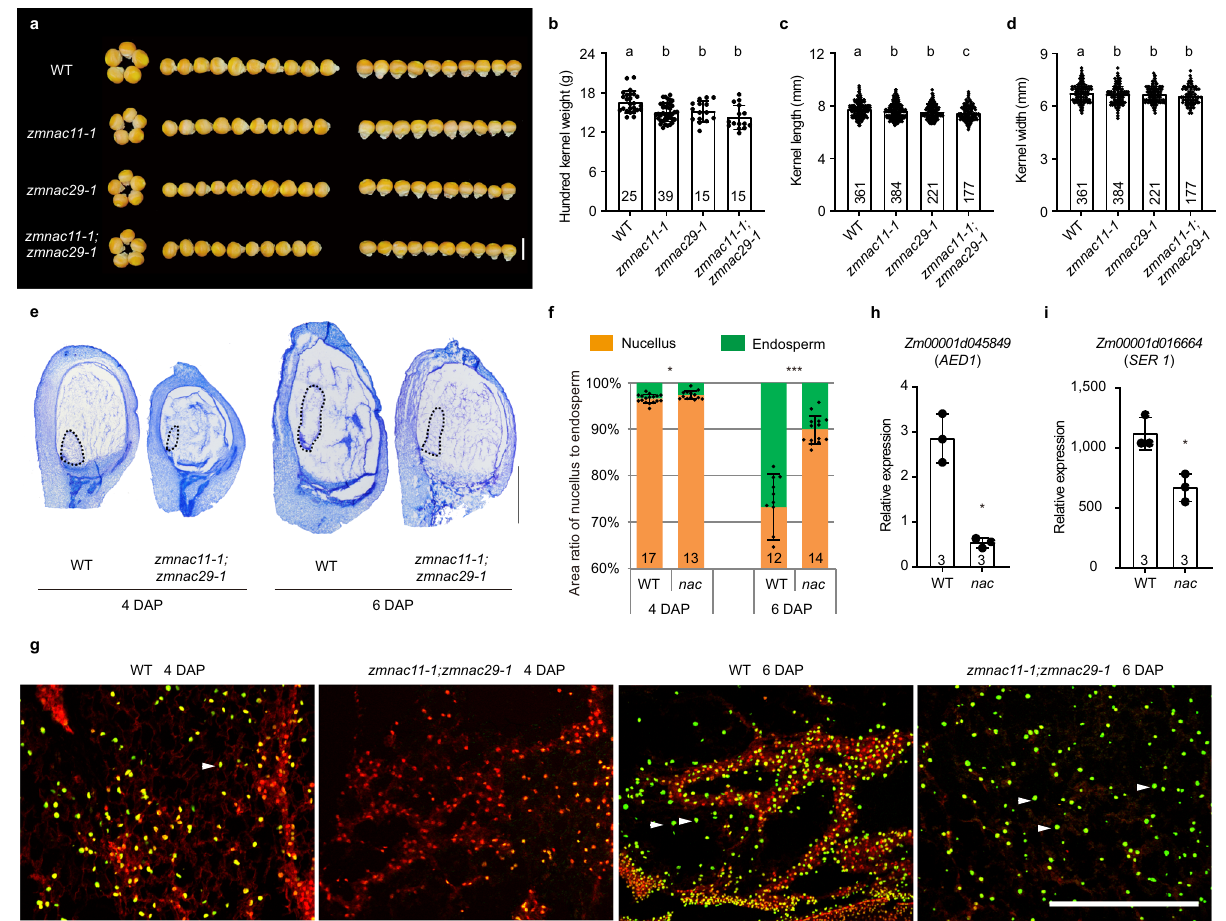
Fig. 6 | Mutationsin ZmNAC11 and ZmNAC29 causesimilar defectsto zmexpb15 in kernel development. a The mature kernels of zmnac11-1 , zmnac29-1 and zmnac11-1 ; zmnac29-1 in comparison to the wild type (WT) in C01 background. b – d Quantitativeanalysisofhundredkernelweight( b ),kernellength( c )andkernel width ( d ) of wild type (WT), zmnac11-1 , zmnac29-1 and zmnac11-1 ; zmnac29-1 . e Toluidine blue sections of WT and zmnac11-1 ; zmnac29-1 kernels at 4 and 6 DAP. f Ratioofnucellus(orangebox)toendospermarea(greenbox)of4-DAPand6-DAP kernelsin zmnac11-1 ; zmnac29-1 ( nac )doublemutantincomparisontothewildtype (WT) control. Longitudinal median sections with maximum area of the entire endospermwereexaminedandquanti fi ed. g TUNELassaysofthenucellusat4and 6 DAP of WT and zmnac11-1 ; zmnac29-1 double mutant. WT kernel at 4 DAP has strong TUNEL-positive signals in nucellar cells (white arrow), whereas zmnac11-